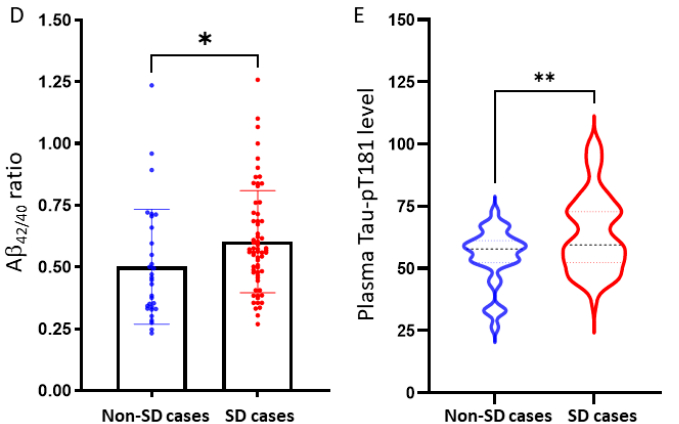
Figure 2. The differences of neuropsychological scores and blood biomarkers between SD cases and non-SD cases, including MOCA score ( A ), HRSD-24 score ( B ), HAMA score ( C ), A β 42/40 ratio ( D ), and Tau-pT181 level ( E ). The asterisk indicates a significant difference between the groups (* p < 0.05, ** p < 0.01, Student t -test).